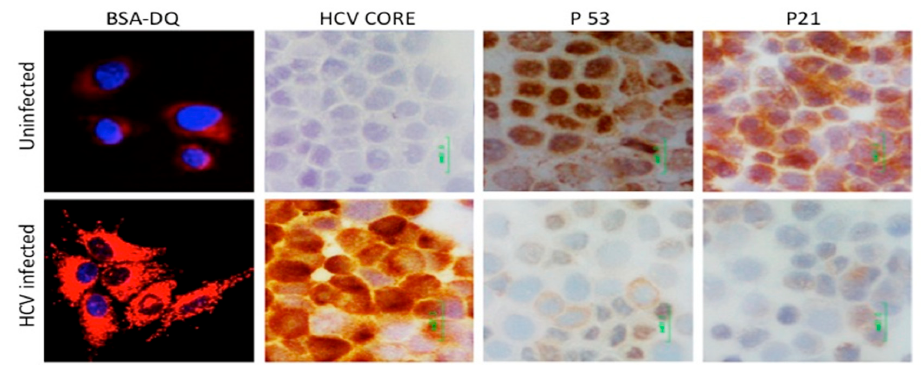
Figure 6. Persistent HCV infection in cell culture degrades p53 tumor suppressor and p53 target genes. Huh ‐ 7.5 cells were infected with HCV JFH1 chimera virus expressing firefly